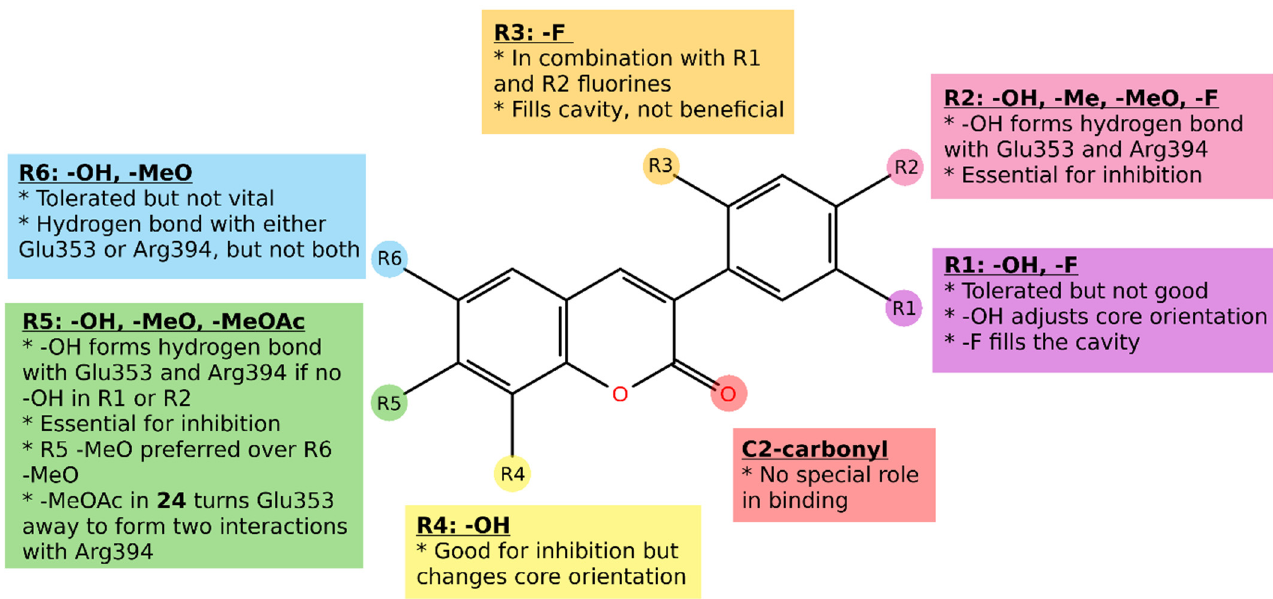
Figure 6. The docking-based structure–activity relationship analysis of the 3-phenylcoumarin derivatives with ER α . Although C2-carbonyl of the coumarin core does not form direct interactions in the ER α binding site, it helps in maintaining the planar geometry of the compounds.